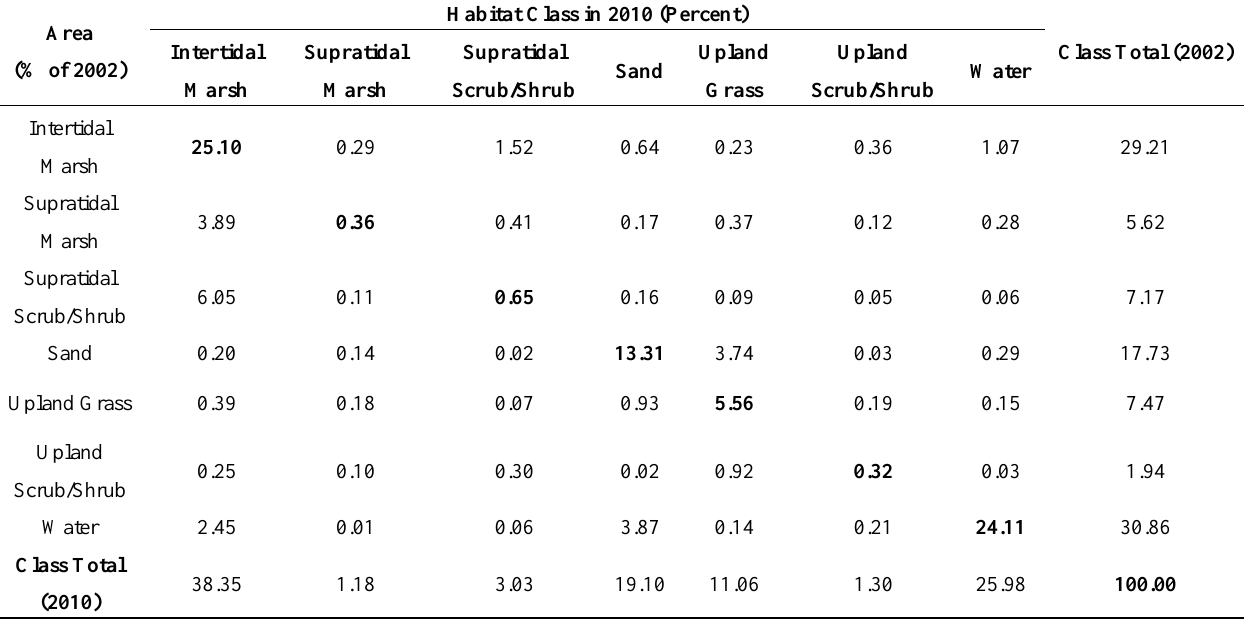
* Areas in beige are the rest of the study area, and not just persistent scrub-shrub. Table 7. Percent change in habitats at Masonboro Island from 2002 to